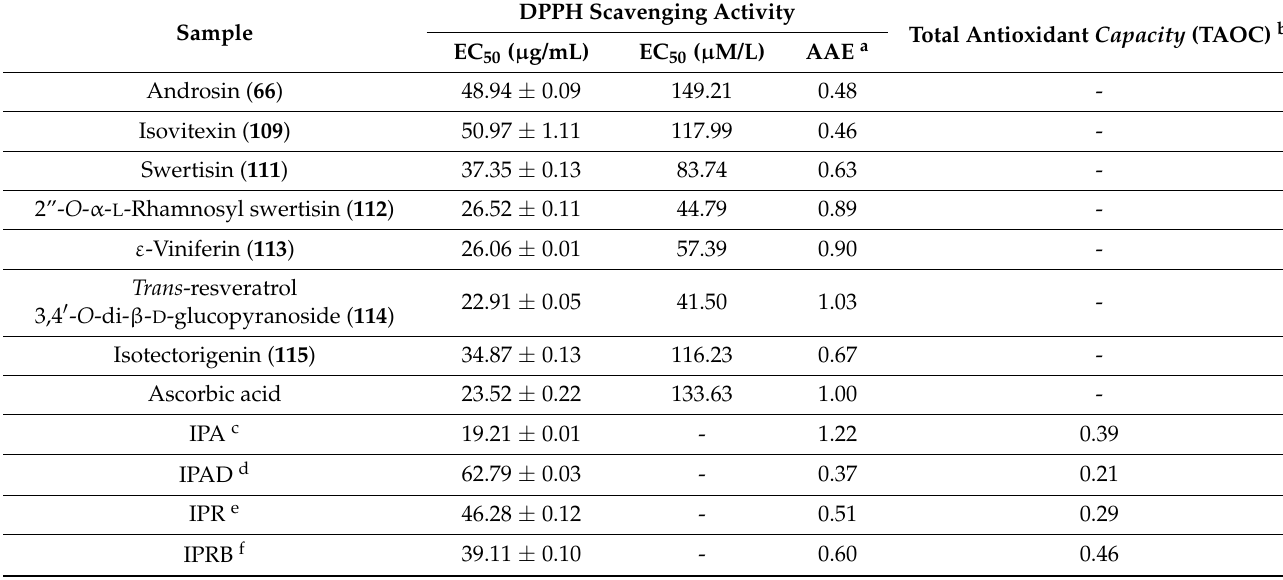
Table 2. Antiradical and antioxidant activities of extracts and compounds isolated from Iris postii